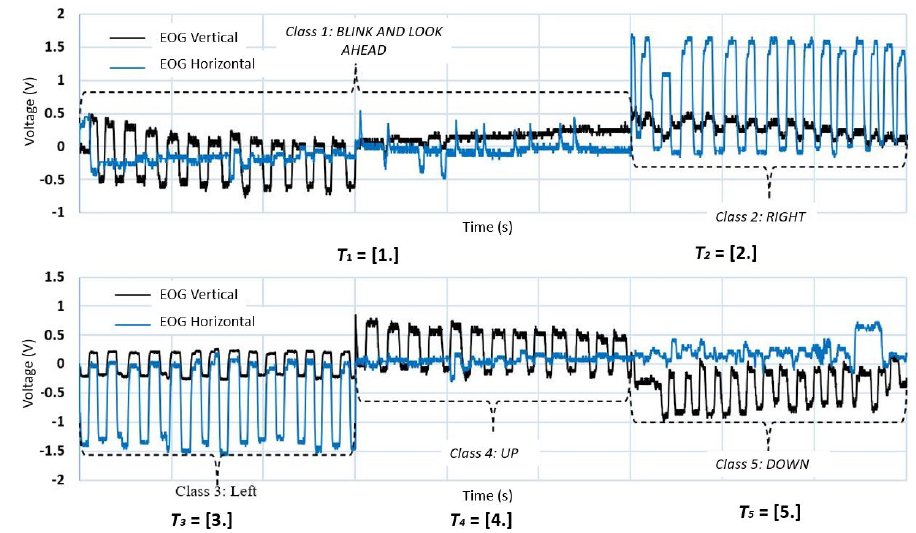
Figure 16. Graphical representation of the dataset (input vector p 2 ). Input vector p 2 represents the class 1: Blink and look ahead; class 2: Right; class 3: Left; class 4: Up and class 5: Down, and output vector T 2 labeling stored by one-hot encoding of each